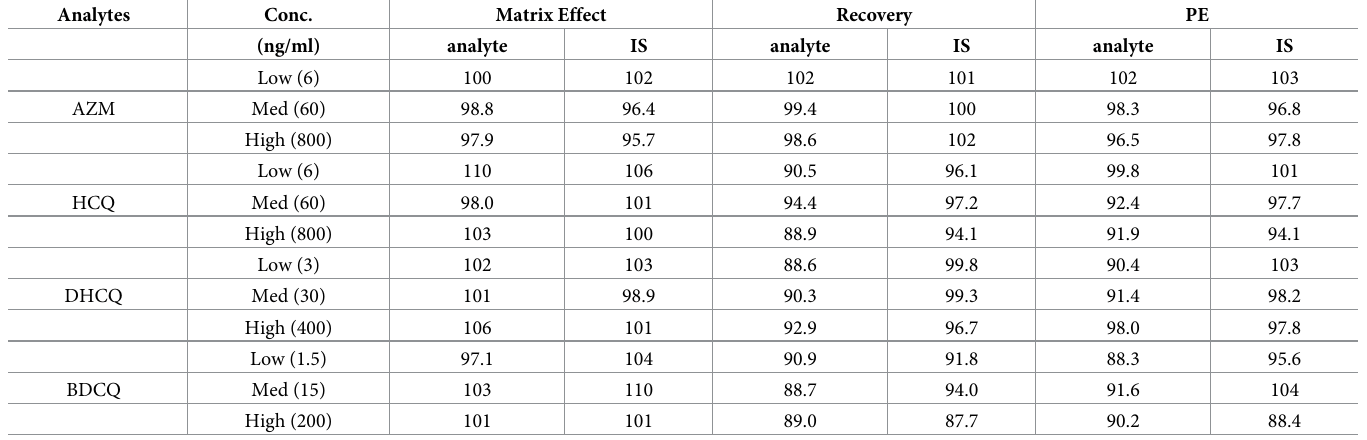
Table 6. Matrix effect, recovery and process efficiency. Analytes